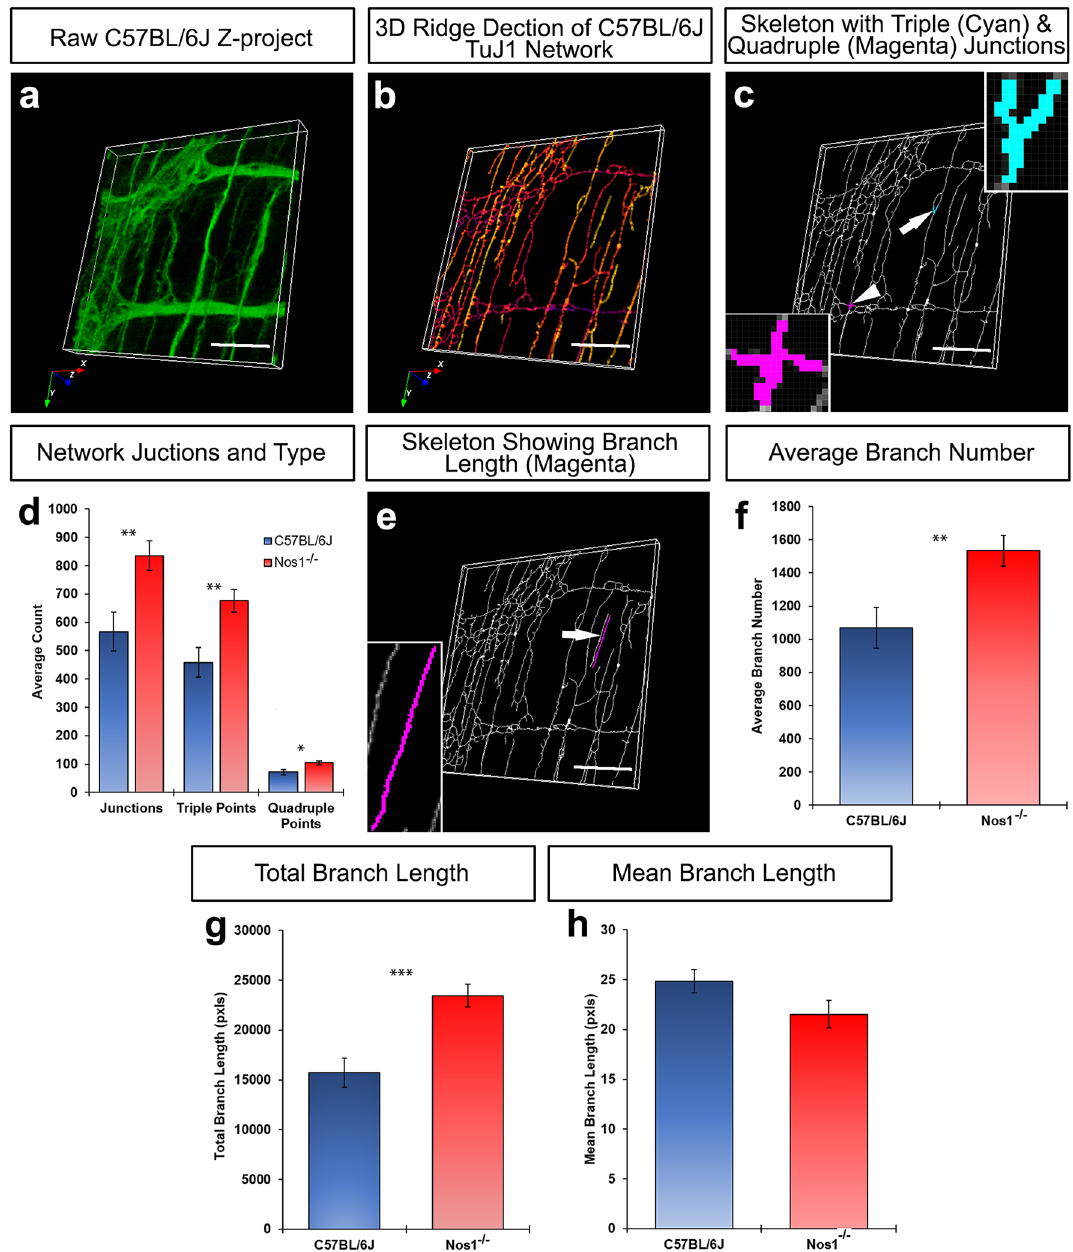
Figure 5. Altered ENS branching and junctioning in the Nos1 −/− distal colon. ( a ) Representative confocal 3D view demonstrating the TuJ1 + (green) network in the C57BL/6J distal colon. ( b ) A twice eroded skeletonised version of a, produced through ridge detection, projected in 3D and pseudocoloured in ‘mpl-plasma’. Colours represent z-depth with yellow being the most superficial structures, moving gradually to purple with increasing z-depth. ( c ) A binary, true skeletonised network (i.e., 1 pixel) of a. Upper inset shows a zoomed image of a representative pseudocoloured (cyan) triple junction (arrow). Lower inset shows a zoomed image of a representative pseudocoloured (magenta) quadruple junction (arrowhead). ( d ) Summary data showing junctional analysis between C57BL/6J (blue bars) and Nos1 −/− (red bars). ( e ) Representative image of binary, true skeletonised network of a showing a representative pseudocoloured (magenta) branch (arrow). ( f – h ) Summary data showing total branch number ( f ), total branch length ( g ) and mean branch length ( h ), in C57BL/6J (blue bars) and Nos1 −/− (red bars) mice. *P ≤ 0.05, **P ≤ 0.01, *** P ≤ 0.001 by Welch’s Student t-test. Scale bars, 50